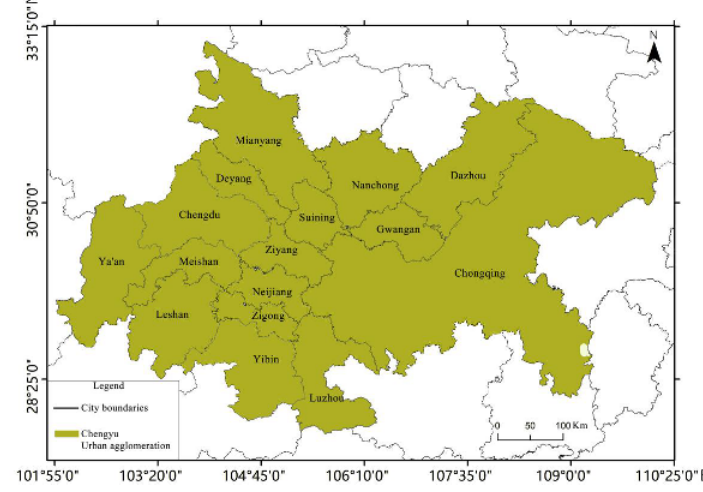
Fig. 1. The geographical location of the study area is